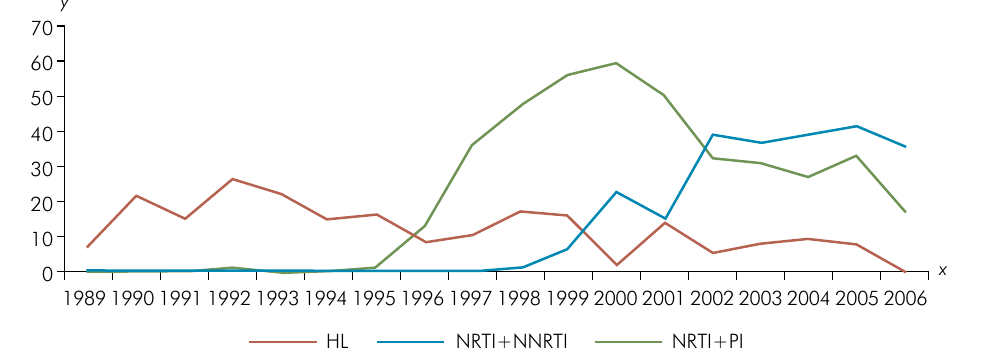
Figure 2. Annual incidence of hairy leukoplakia and the type of ARVT used by 1600 HIV-positive patients.